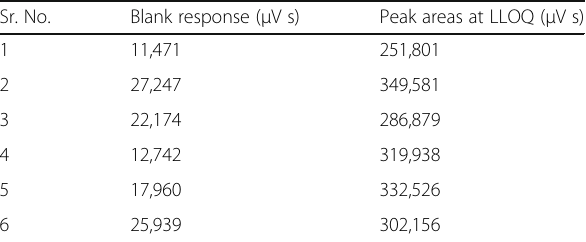
Table 4 Blank responses and LLOQ peak areas for chlorthalidone Sr. No.